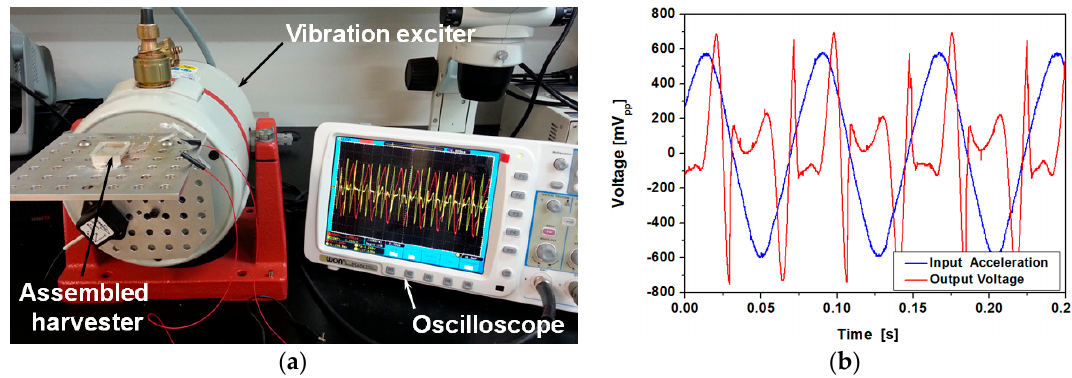
Figure 7. ( a ) Experimental setup for the vibration exciter test; ( b ) input acceleration and open-circuit voltage of the device with 5 uL ferrofluid (3 g acceleration at 13 Hz applied).